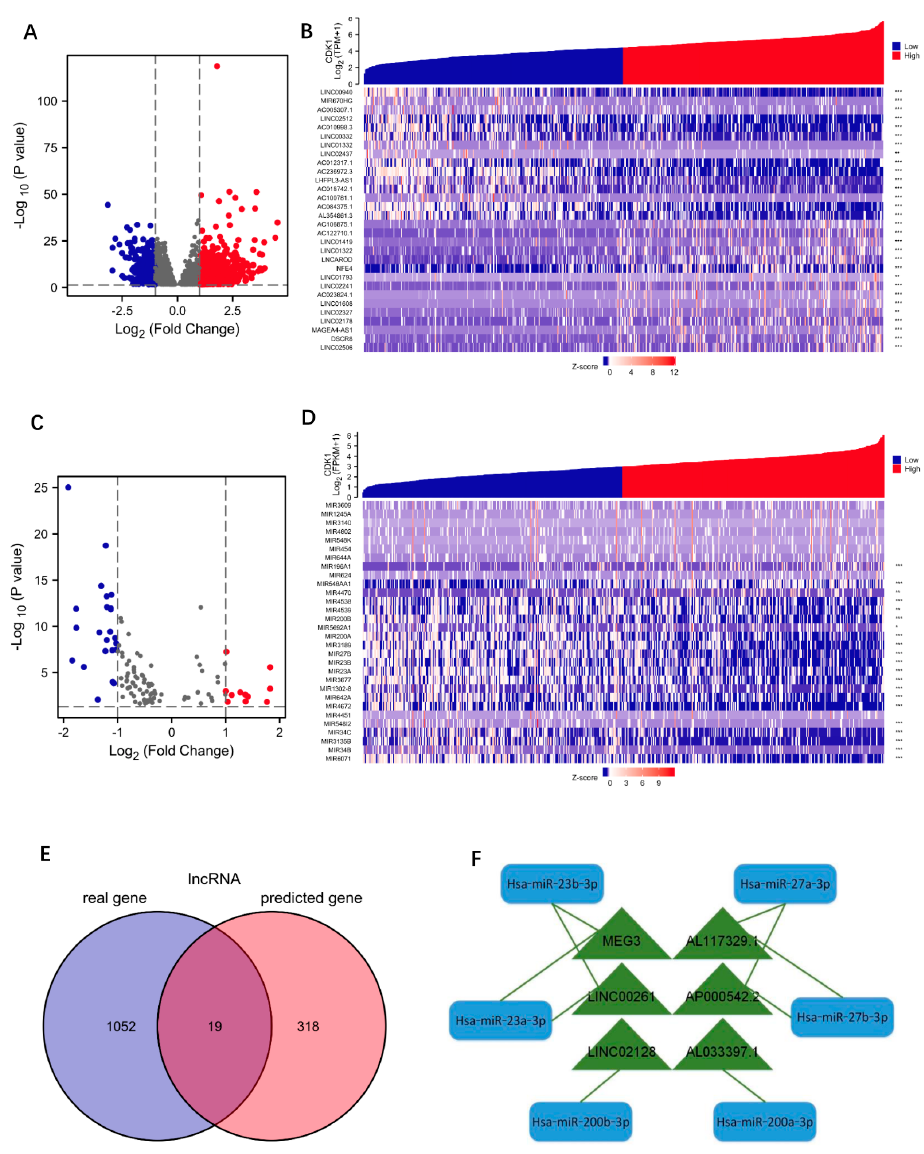
Figure 2. Exploration of CDK1-associated DEGs. ( A ) The volcano plots describe DElncRNAs. log 2 foldchange > 1 or log 2 foldchange < − 1, * p < 0.05. ( B ) CDK1-associated co-expression heatmap with the top 30 DElncRNAs. Significance markers: ** p < 0.01; *** p < 0.001. ( C ) The volcano plots describe DEmiRNAs. log 2 foldchange > 1 or log 2 foldchange < − 1, * p < 0.05. ( D ) CDK1-associated co-expression heatmap with the top 30 DEmiRNAs. Significance markers: ** p < 0.01; *** p < 0.001. ( E ) The lncRNAs related to CDK1 are represented by Venn diagram. ( F ) CDK1-associated